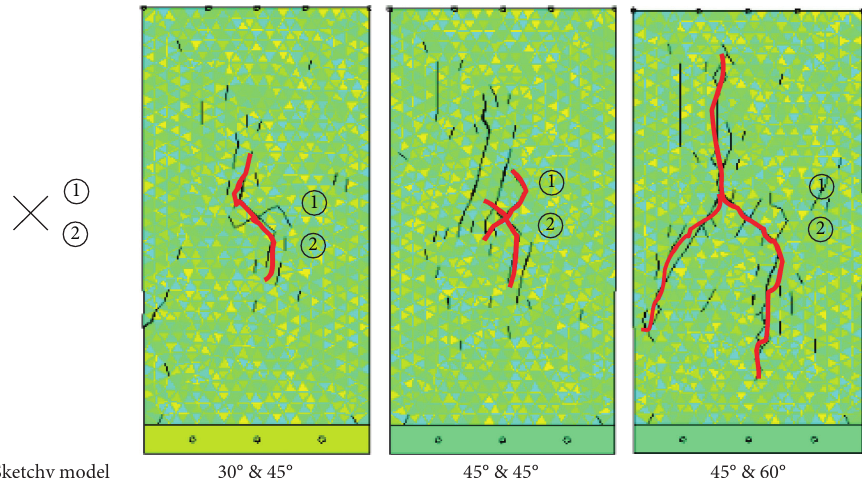
Figure 6: DDARF simulation on the failure mode of single “X” fracture specimen with different